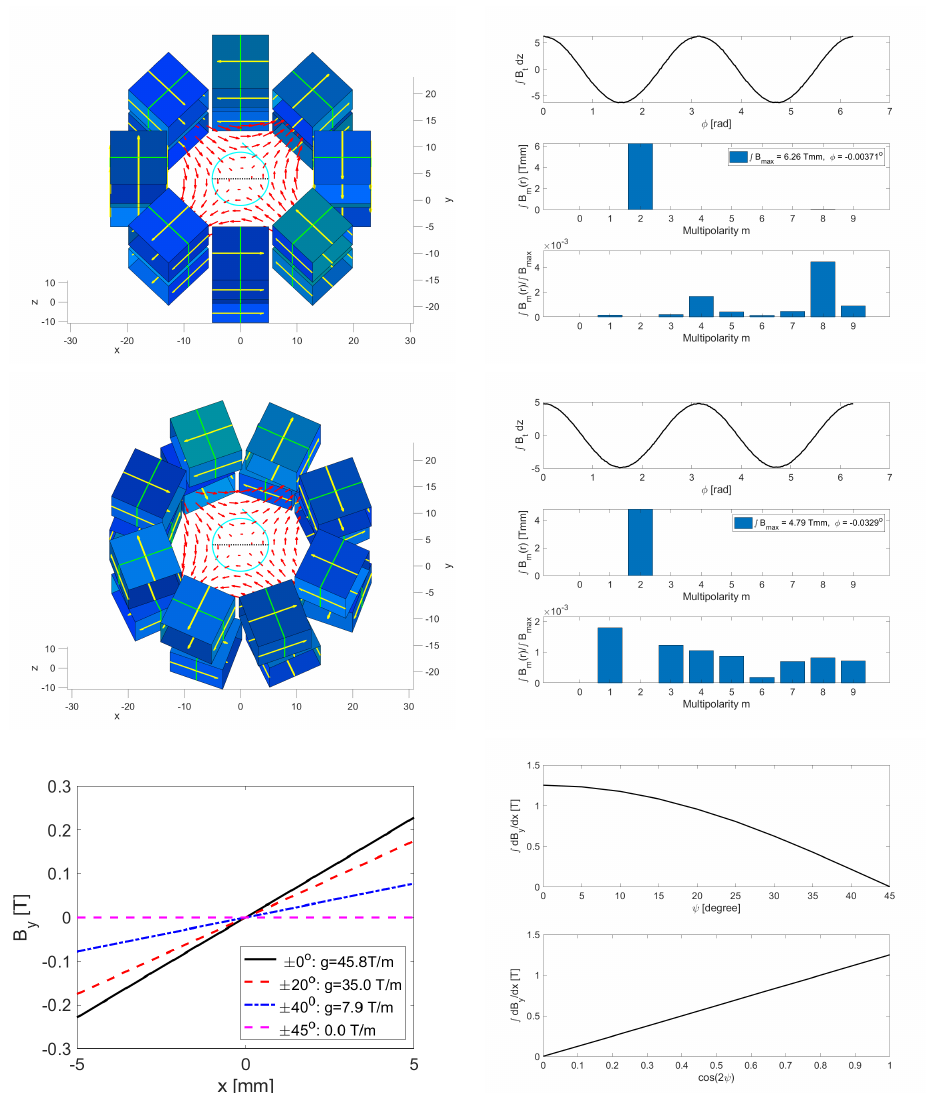
Figure 7. Top left: two rings for a variable quadrupole aligned on top of each other. Top right: the tangential field on the cyan circle (upper), the dominant field harmonic (middle), and the relative strength of the unwanted harmonics (bottom). Middle row: the corresponding images for rings rotated with ψ = 20 ◦ . The amplitude was reduced, but the unwanted harmonics were similar to the plot above. Bottom left: the gradient along the black dotted line for different rotation angles ψ . Bottom right: the integrated gradient as a function of the rotation angle ψ (upper) and as a function of cos2 ψ